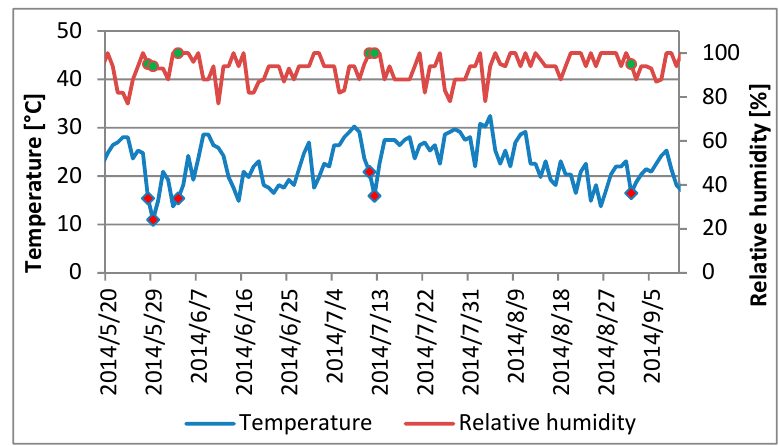
Figure 7. Time course of temperature and relative humidity in 2014 (Warsaw station) together with indicators of days when the relative value of the prediction was >50%.